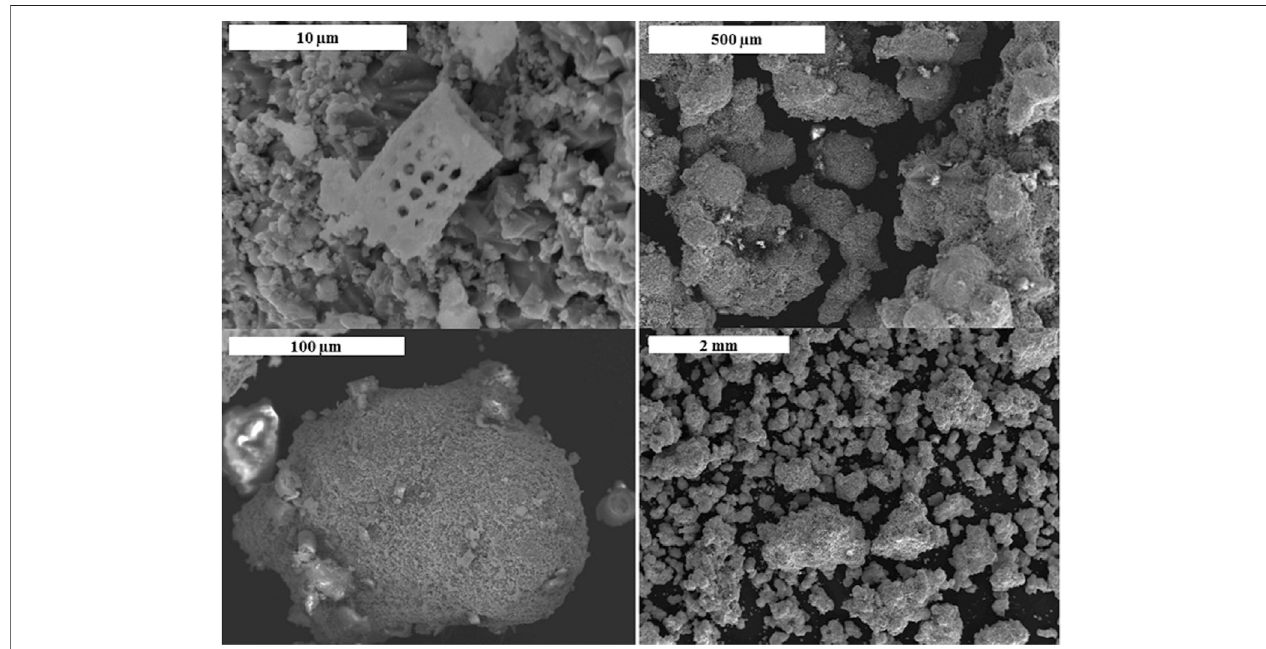
FIGURE 15 | SEM image of the sample DE-Iron (0-250)-2-OX-2 under various magni fi cations.